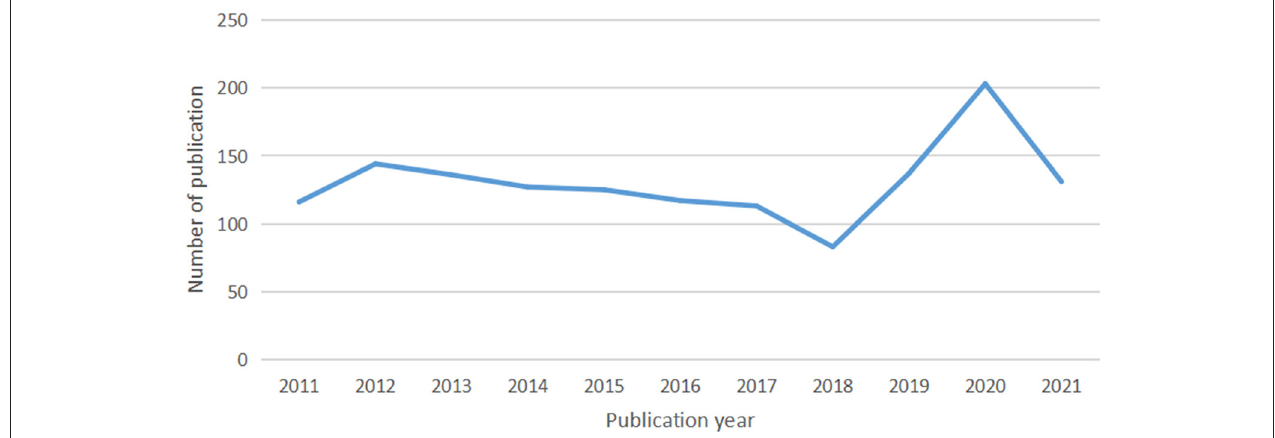
FIGURE 1 | Annual output of atrophic gastritis (AG) research.